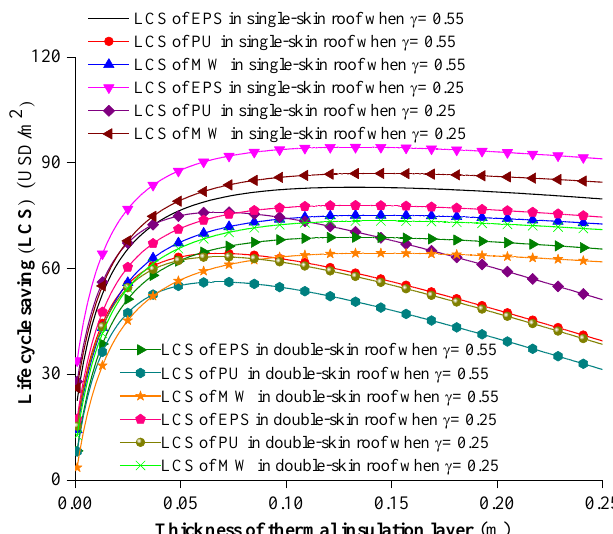
Figure 7. Life cycle net present value of roof thermal insulation. The maximum LCS value of EPS, PU, and MW are 83.05, 64.31, and 75.11 USD/m 2 for the single-skin roof with a 0.55 solar radiation reflectivity coefficient, respectively. The maximum LCS values of EPS, PU, and MW are 94.41, 76, and 86.96 USD/m 2 for the single-skin roof with a 0.25 solar radiation reflectivity coefficient, respectively. The maximum LCS values of EPS, PU, and MW are 68.85, 53.97, and 64.39 USD/m 2 for the double-skin roof with a 0.55 solar radiation reflectivity coefficient, respectively. The maximum LCS values of EPS, PU, and MW are 77.9, 63.34, and 73.52 USD/m 2 for the double-skin roof with a 0.25 solar radiation reflectivity coefficient,